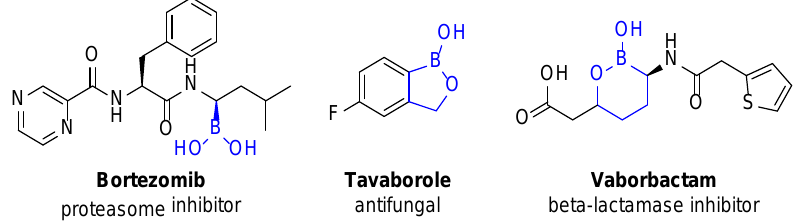
Scheme 1. Scaffold hopping strategy for compound M1.